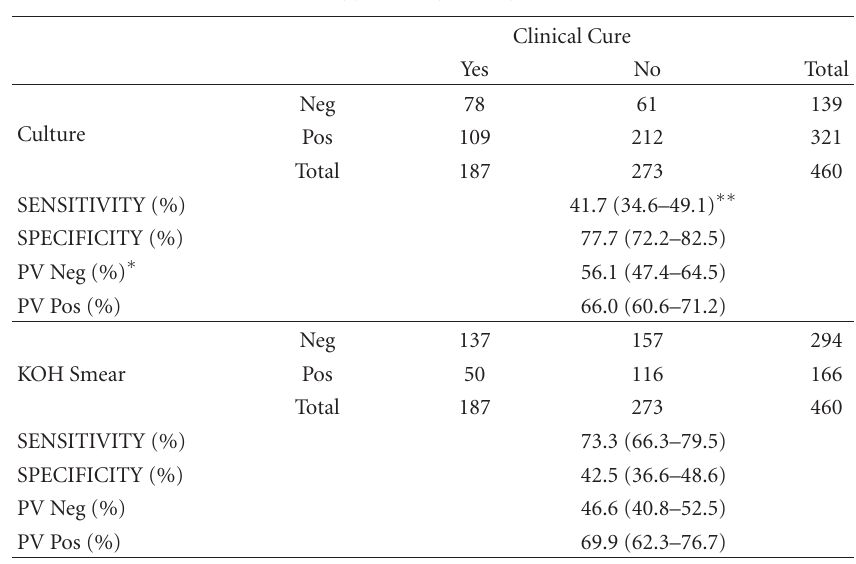
Table 5: Sensitivity, specificity, and predictive value for KOH smear and culture with clinical cure at six weeks as gold standard overall and for component studies